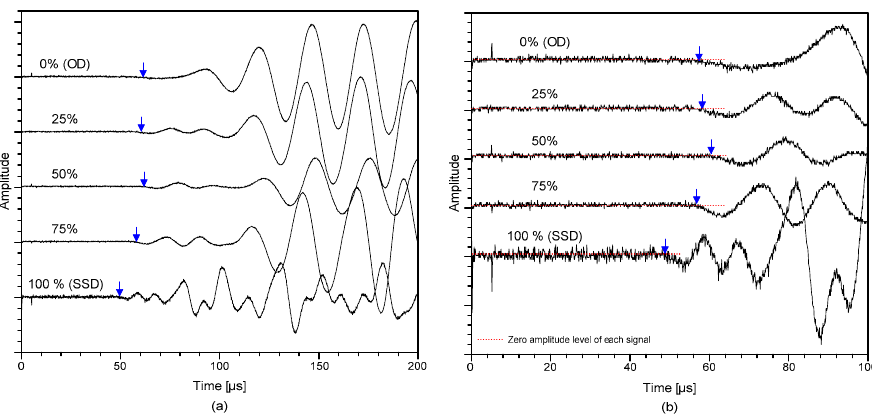
Figure 4. Typical time signals of ultrasonic pulse waves (P-wave) propagating through saturated concrete cylinders: ( a ) ultrasonic waves at different saturation levels and ( b ) enlarged ultrasonic signals around the first arrival of the wave (P-waves) shown in Figure 4a.